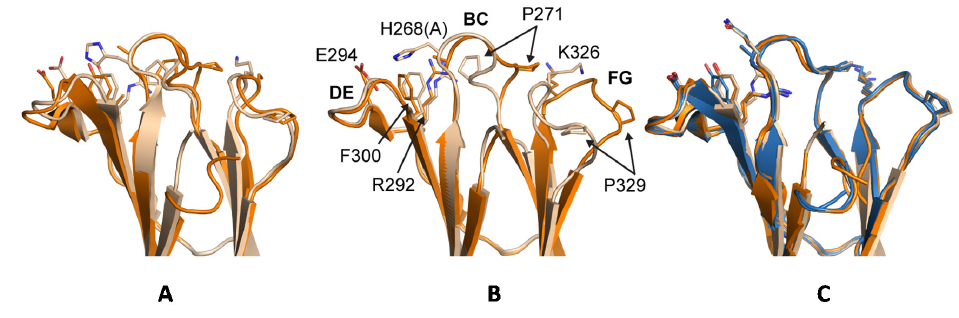
Figure 13. Conformational differences in BC and FG loops in WT and σ variants of huIgG. ( A ) Overlay of C H 2 domains (cartoon) from huIgG1 (wheat, PDB 3AVE chain A [40]) and huIgG1 σ (orange, chain B); ( B ) huIgG2 (wheat, PDB 4HAF chain A [49]) and huIgG2 σ (orange, PDB 4L4J chain A [29]); ( C ) huIgG4 (wheat, PDB 4C54 chain A [50]), huIgG4 σ 1 (blue, chains A and B), and huIgG4 σ 2 (orange, chains A and B). BC and FG loops are in the flipped ‐ in conformation in huIgG1 (middle, wheat) and flipped ‐ out conformation in huIgG2 σ (middle, orange). Residues at positions 268, 271, 292, 294, 300, 326, and 329 are shown as sticks and are labeled in the middle panel with huIgG2 sequence (mutation at position 268 in huIgG2 σ given in parentheses). N ‐ terminal residues 234–236 are omitted from the cartoon of huIgG1 for clarity, and the alternate conformations modeled for the BC loop of huIgG1 σ are shown.